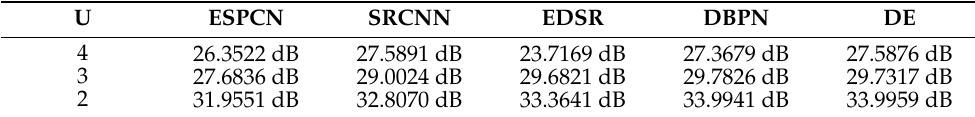
Table 4. Comparison of different methods using the Satellite dataset II (East Asia). Among them, ESPCN and our DE module were mentioned above; their PSNR values are also listed here. U ESPCN SRCNN EDSR DBPN DE 4 26.3522 dB 27.5891 dB 23.7169 dB 27.3679